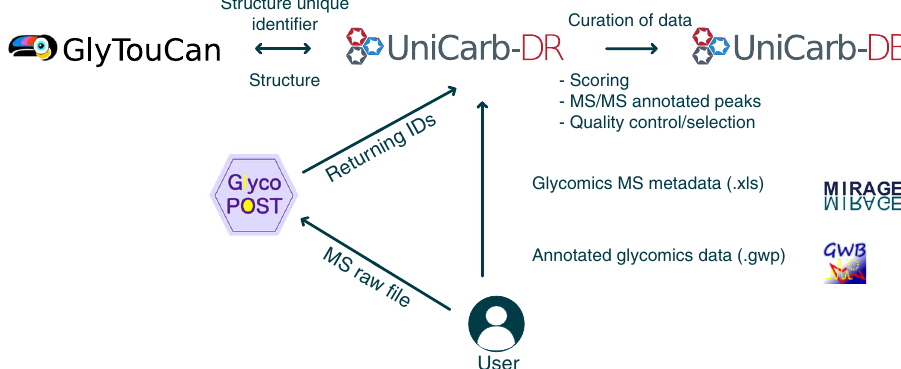
Fig. 2 Work fl ow for MIRAGE data submission to UniCarb-DR. The work fl ow was designed to support the MIRAGE guidelines for sample preparation, including HPLC, MS and annotation. Metadata that are relevant to the entire experiment can be manually recorded in the on-line form accessible on the UniCarb-DR website (http://unicarb-dr.biomedicine.gu.se/) that automatically generates spreadsheets (.xls). GlycoWorkBench fi les (.gwp) are proposed to be used for data annotation of individual structures. MS raw fi les can be submitted to GlycoPOST and returned IDs can be included in the MIRAGE report. UniCarb-DR also communicates with the global glycostructure repository GlyTouCan to generate unique identi fi ers for structures submitted to UniCarb-DR. UniCarb-DR will become one source of curated data in